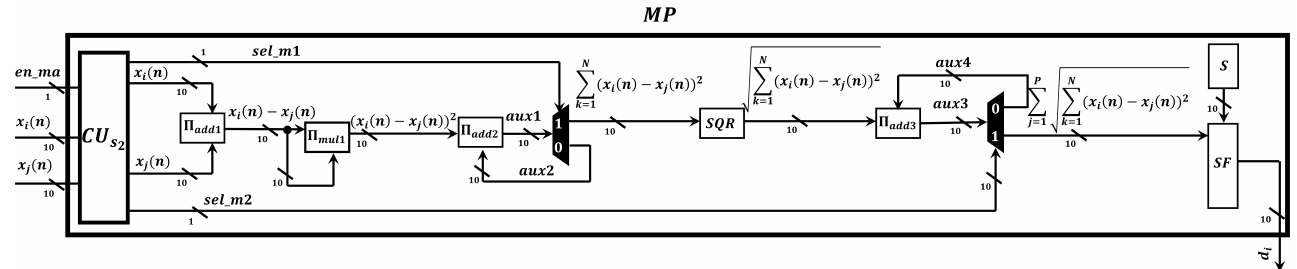
Figure 9. Digital circuit scheme of the Markov proccesor.